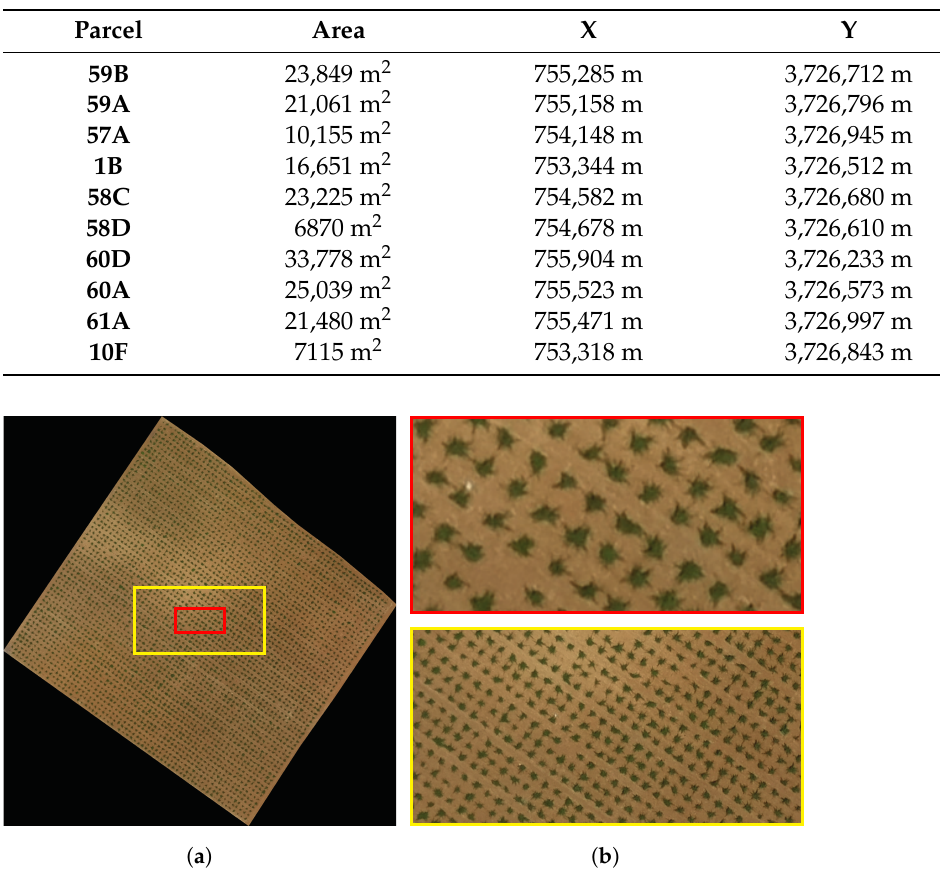
Table 1. Parcels used for experiments.